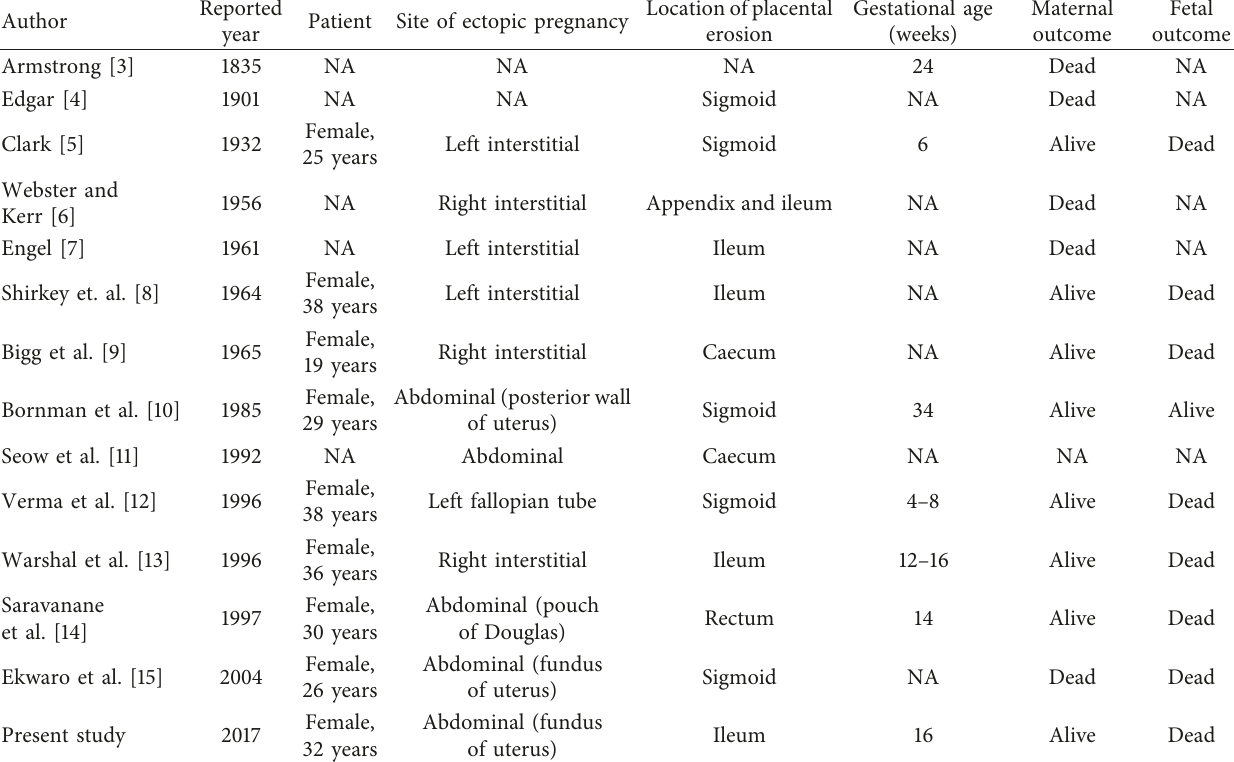
Table 1: Reported cases of intestinal hemorrhage associated with ectopic